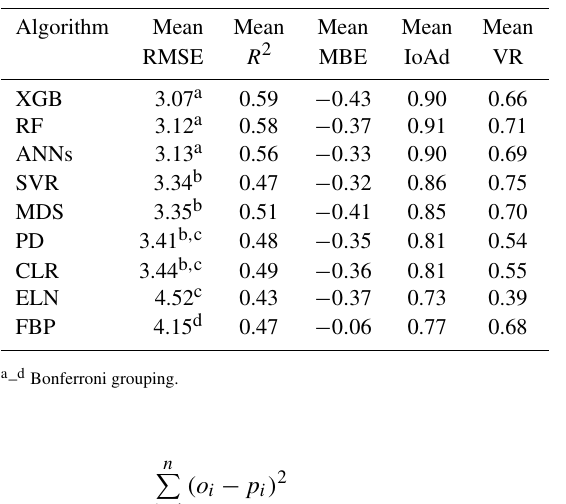
Table 5. The average performance metrics for each gap-filling al- gorithm regarding F c , which includes all window lengths and sites, ranked by RMSE using the Tukey’s HSD test at the level of